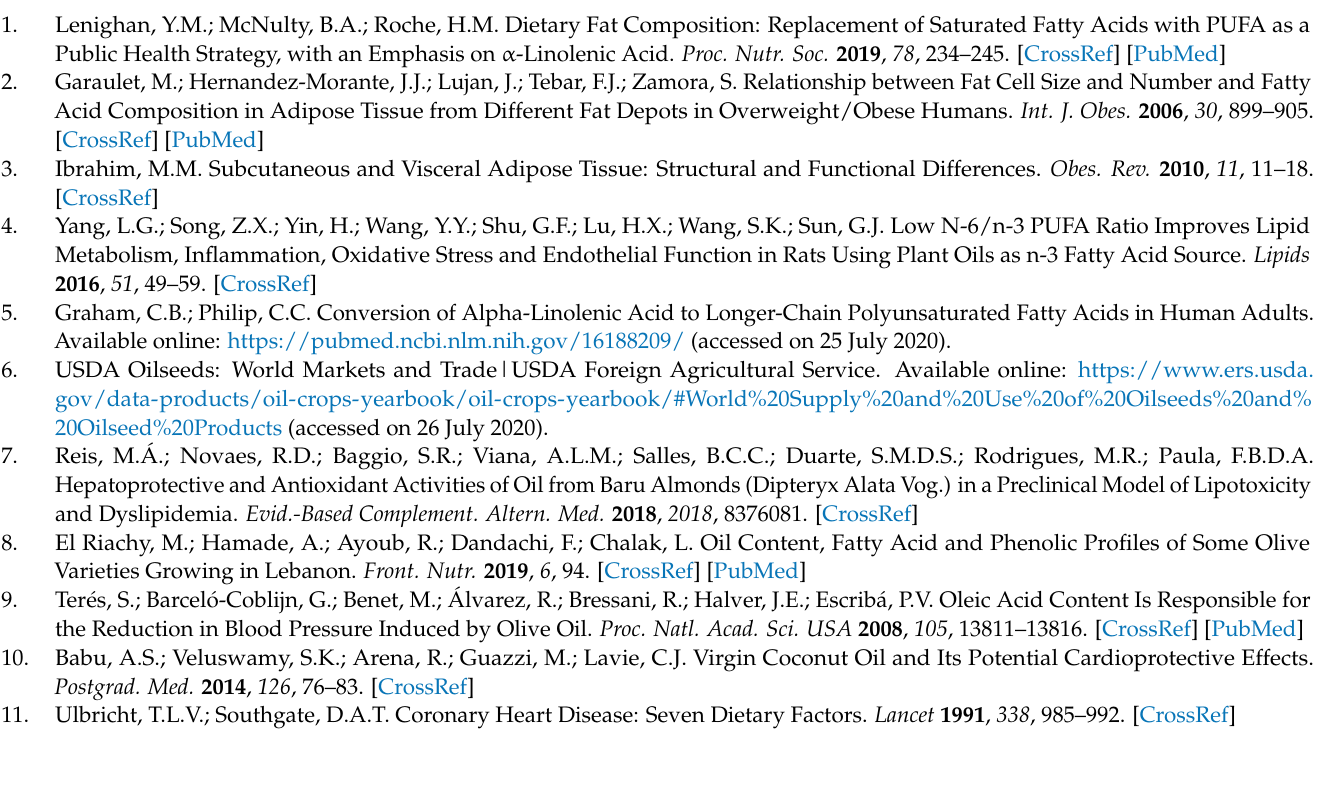
CO, Figure S4: Thermal decomposition of BO (baru oil), CO (coconut oil), LO (linseed oil), and SO (soybean oil), Figure S5: Histological analysis of liver tissue from mice. High magnification (400 × ) photomicrograph, Hematoxylin and eosin stained slided (black arrows indicate macrogoticular steatosis and red arrows indicate hepatocellular ballooning). BG: Baru group; CG: Coconut